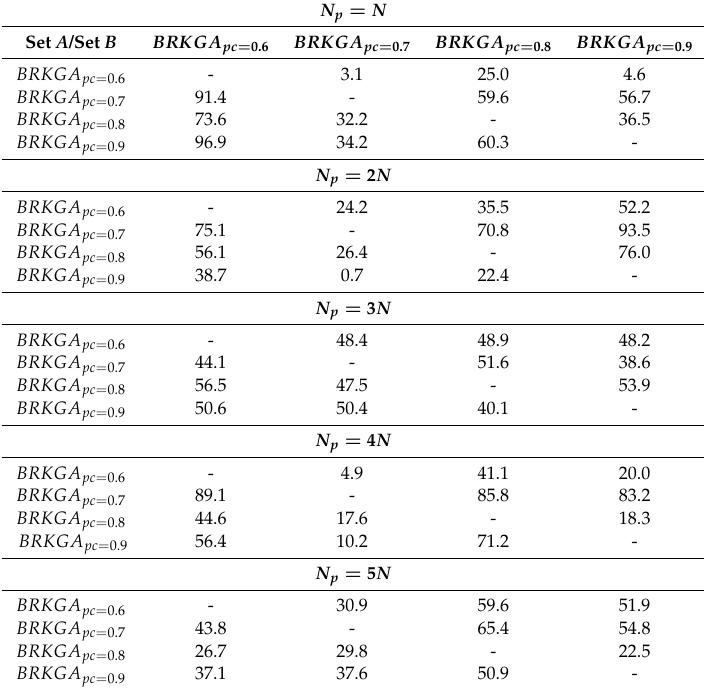
Table 2. Percentage of Non-dominated Solutions of set B covered by those in set A for case study 2. N p = N Set A /Set B BRKGA pc = 0.6 BRKGA pc = 0.7 BRKGA pc = 0.8 BRKGA pc =